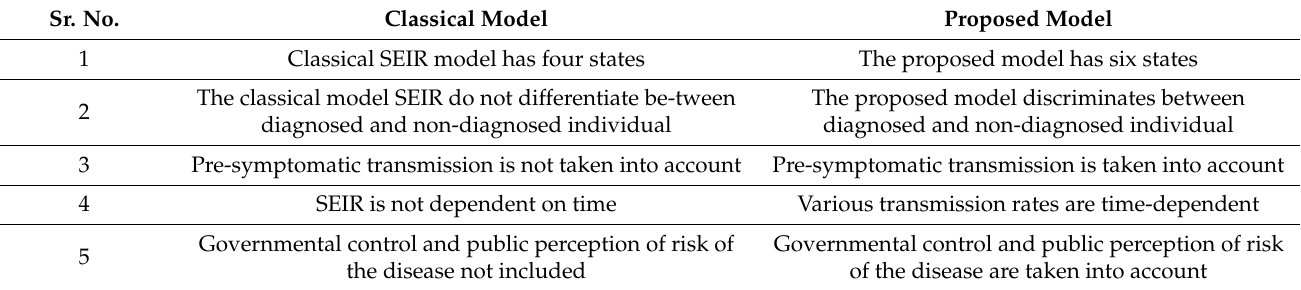
Table 1. Difference between the classical and the proposed